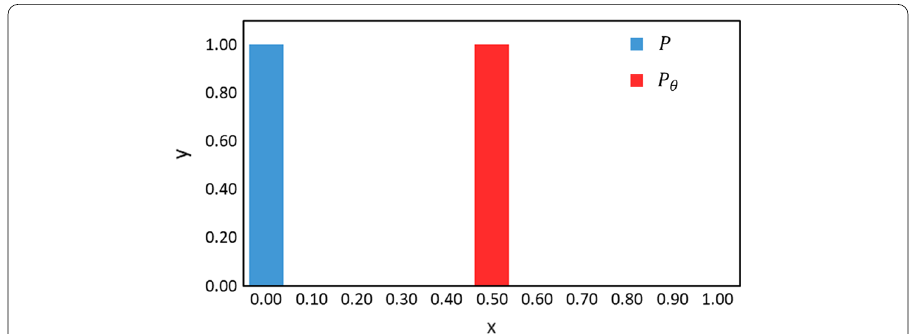
Fig. 3 Two probability distributions P and P θ . If θ = 0 there is no overlap between P and P